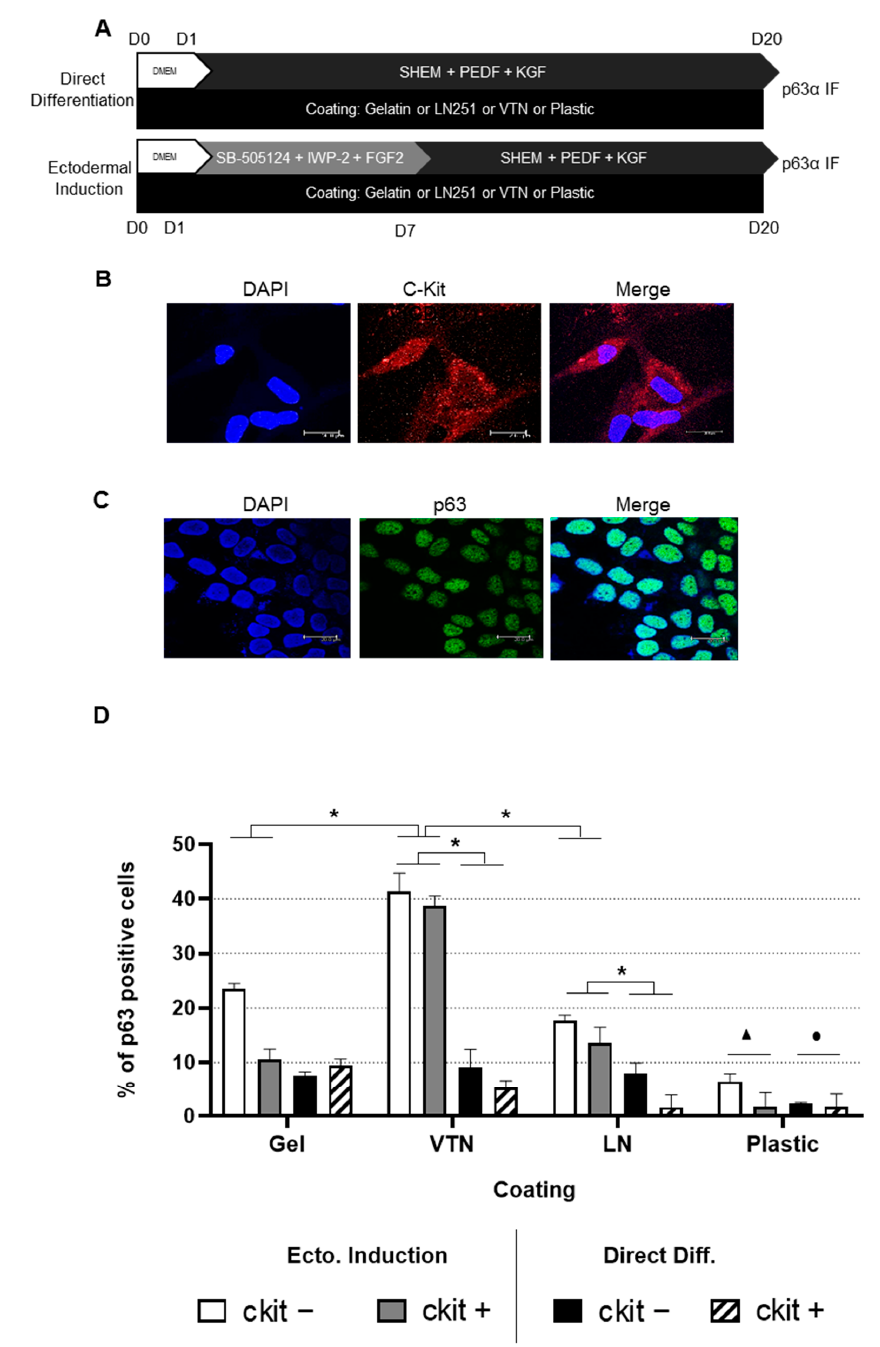
Figure 1. ( A ): Schematic outline of the experimental design for hADSC to LSC differentiation . The culture conditions, coating and duration for each stage are shown. The direct differentiation culture method consisted of culturing hADSCs in supplemental hormonal epithelial medium (SHEM) supplemented with two additional growth factors: pigment epithelium-derived factor (PEDF) and keratinocyte growth factor (KGF) for 20 days. The ectodermal induction method consisted of culturing hADSCs for 1 week with ectodermal induction medium before changing to the differen- tiation medium. Ectodermal induction medium consisted of Dulbecco’s Modified Eagle Medium supplemented with 15% fetal bovine serum, SB-505124, IWP-2 and FGF2. For each culture